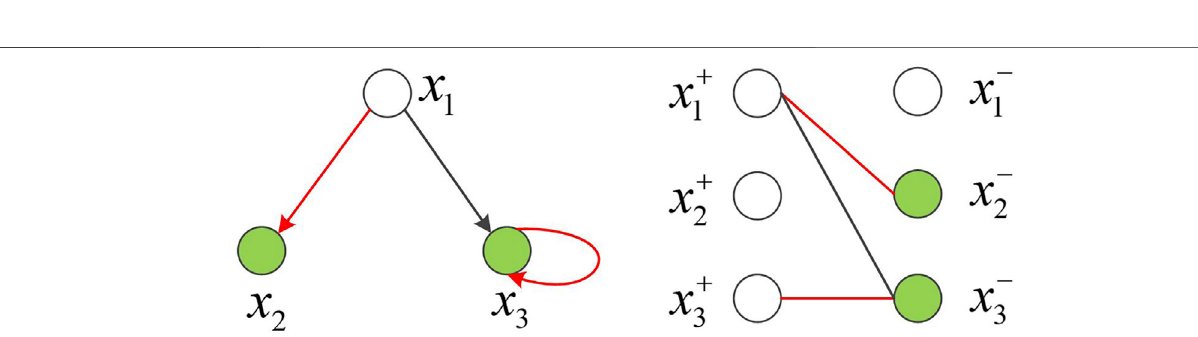
FIGURE 8 | Schematic diagram of three-node network maximum matching.